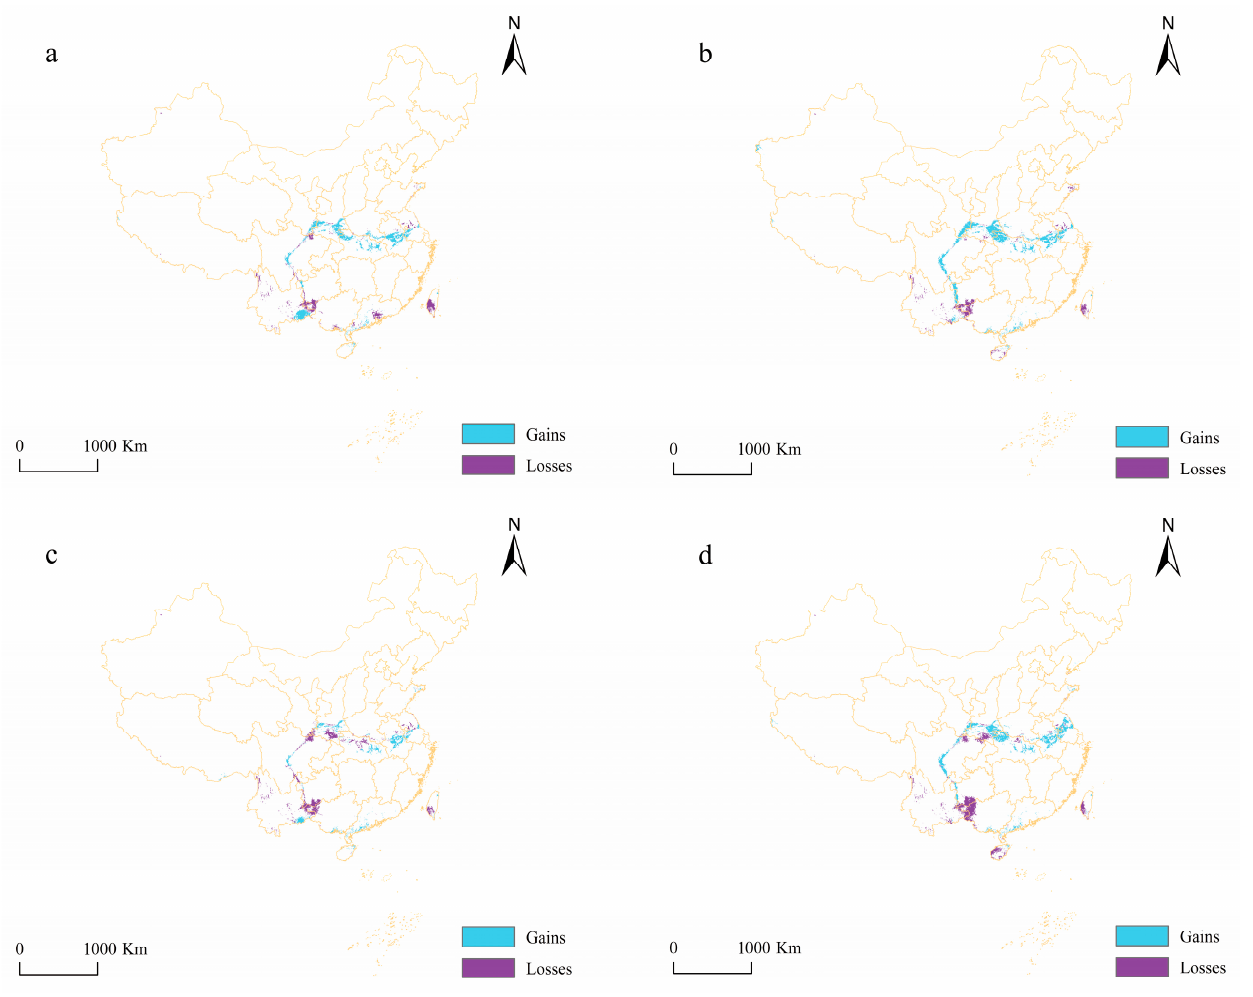
Figure 5. Spatial transformation pattern of Q. spinosa suitable area in different periods. ( a ) Greenhouse gas emission concentration is lowest in 2041–2060; ( b ) greenhouse gas emission concentration is highest in 2041–2060; ( c ) greenhouse gas emission concentration is lowest in 2061–2080; ( d ) greenhouse gas emission concentration is highest in 2061–2080. The increase and loss of suitable areas are derived and compared to current area.